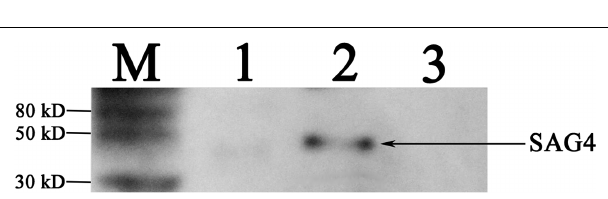
FIGURE 3 | Detection of plasmid expression in vitro by Western blotting. M, protein marker; 1, HEK293T cells transfected with pEGFP-C1; 2, HEK293T cells transfected with pSAG4; and 3, untransfected cells.